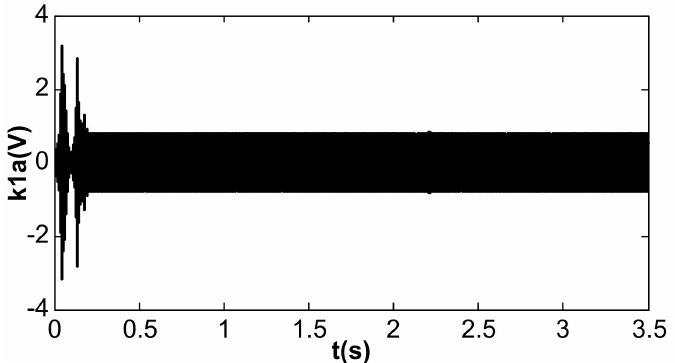
Figure 22. Vibration amplitude of double closed loop ( k I = 240, k II = 20). Figure 23 is a vibration output signal of a resonant beam controlled by a double closed loop, and the vibration amplitude is constant. The signal frequency spectrum in Figure 23 was analyzed after linear transformation. The frequency of the resonance signal was 35.20 kHz, and the resonance frequency was consistent with the open-loop frequency sweep test experiment shown in Figure 24. When we adjusted the DC reference voltage, the vibration amplitude of the microstructure changed accordingly. The system could not start vibration when the DC reference voltage was too small. Changing the time constant of the filter could adjust the starting time of the system. The experimental debugging conclusion is consistent with the theoretical analysis.